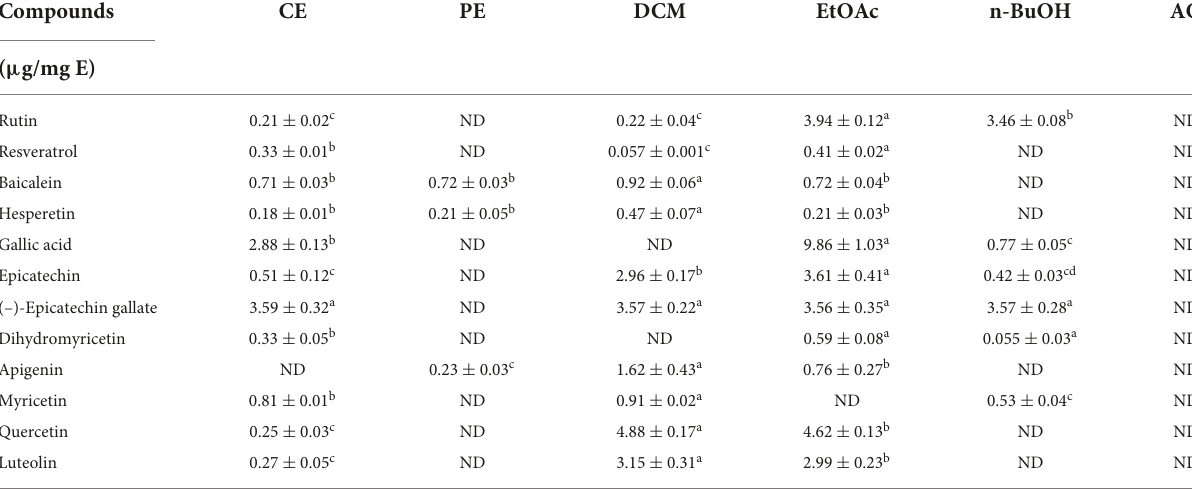
TABLE 2 The contents of individual phenolic compounds in the BCF crude extract and its